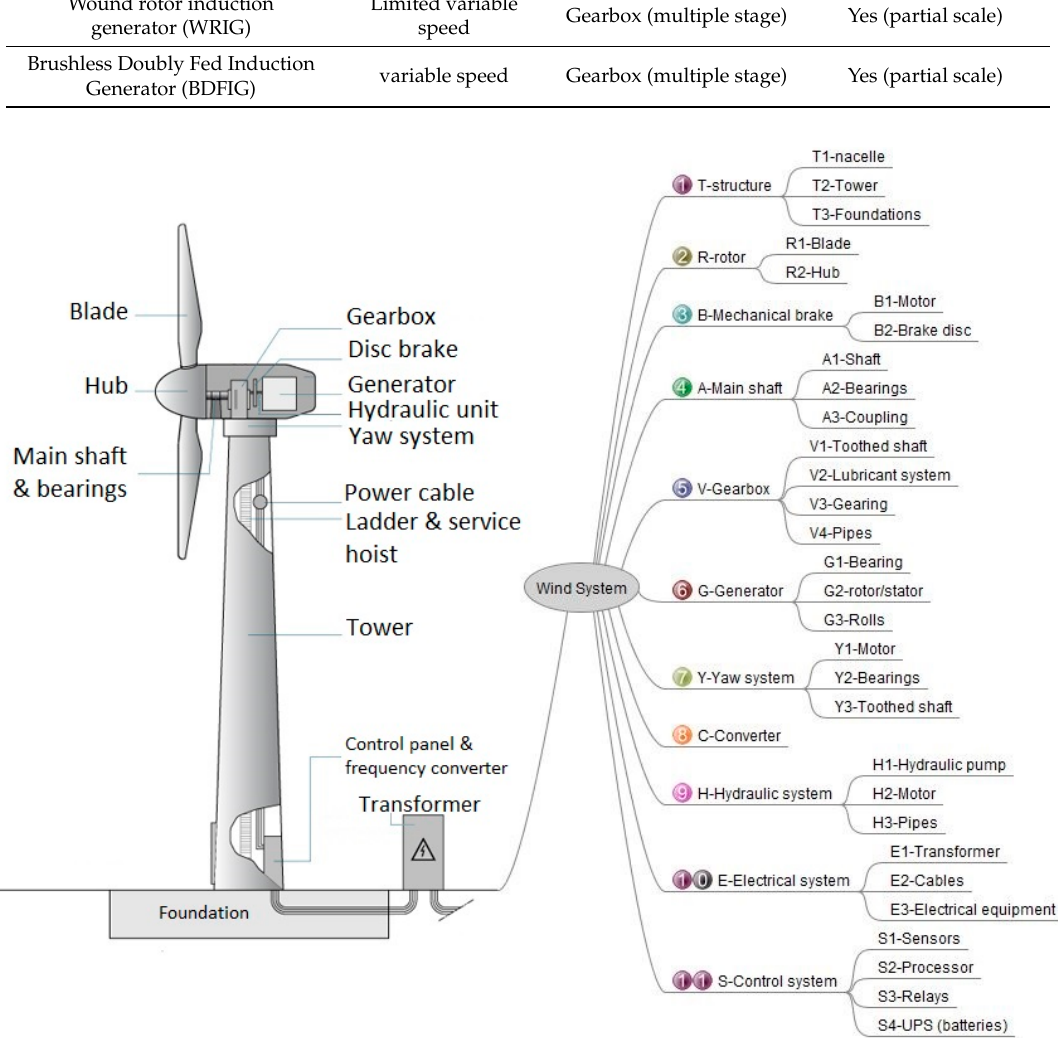
Figure 2. Main components of a 2–3 MW wind turbine.